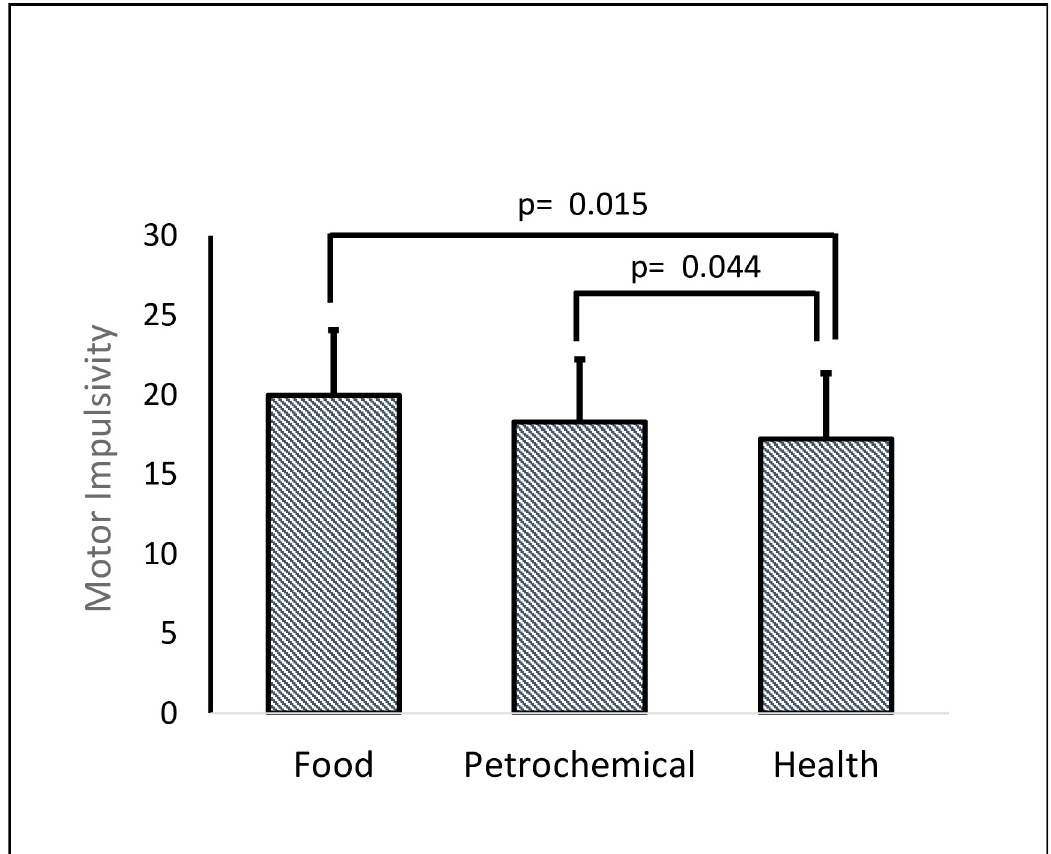
Fig 3. Differences in motor impulsivity levels depending on employment sector.